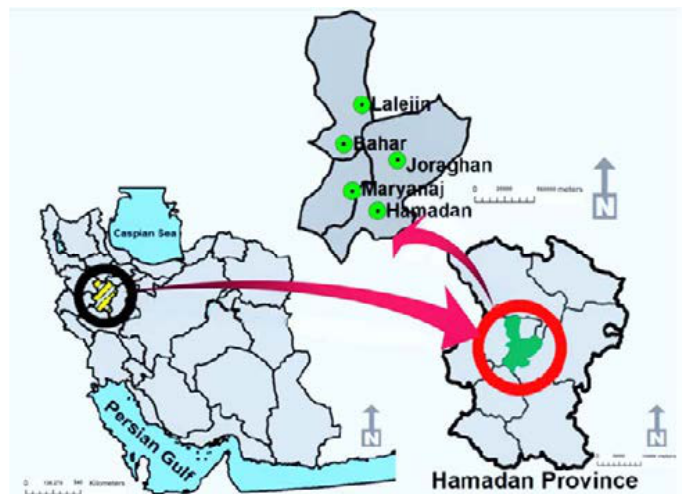
Fig. 1: The geographic location of the study area